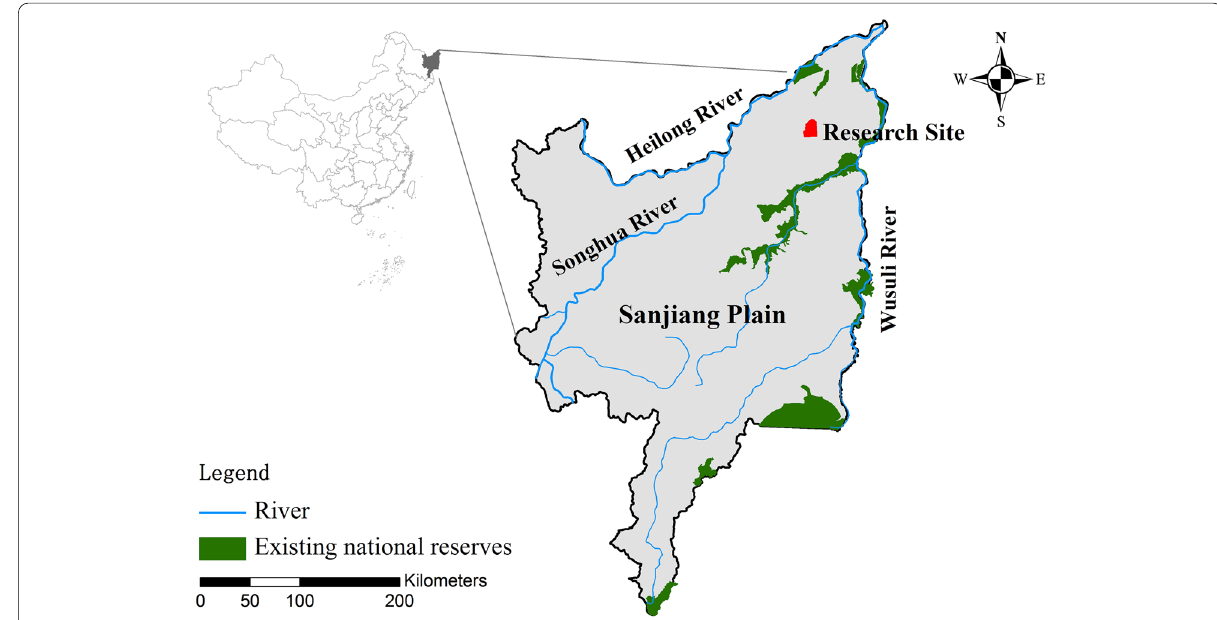
Fig. 7 Map of the research site in the Sanjiang Plain,